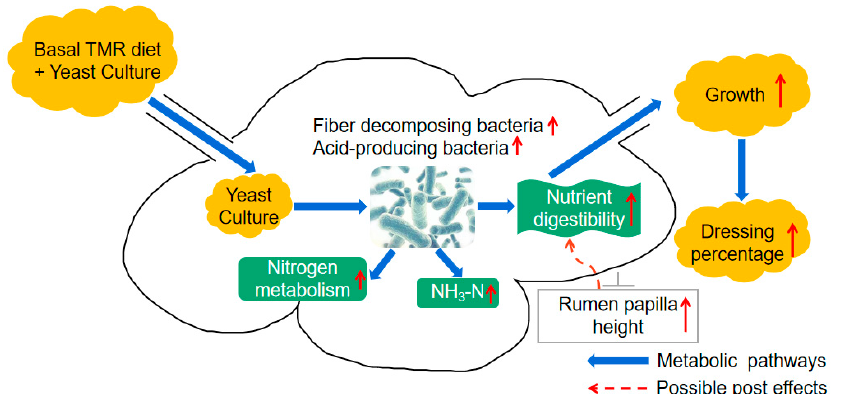
Figure 6. Putative schematic illustration of supplementing yeast culture to promote rumen devel- opment and growth performance of fattening Hu sheep. ↑